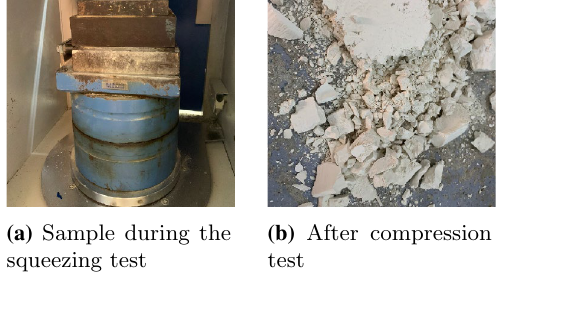
Fig. 13 The effect of the wall thickness on the solidity of the printed